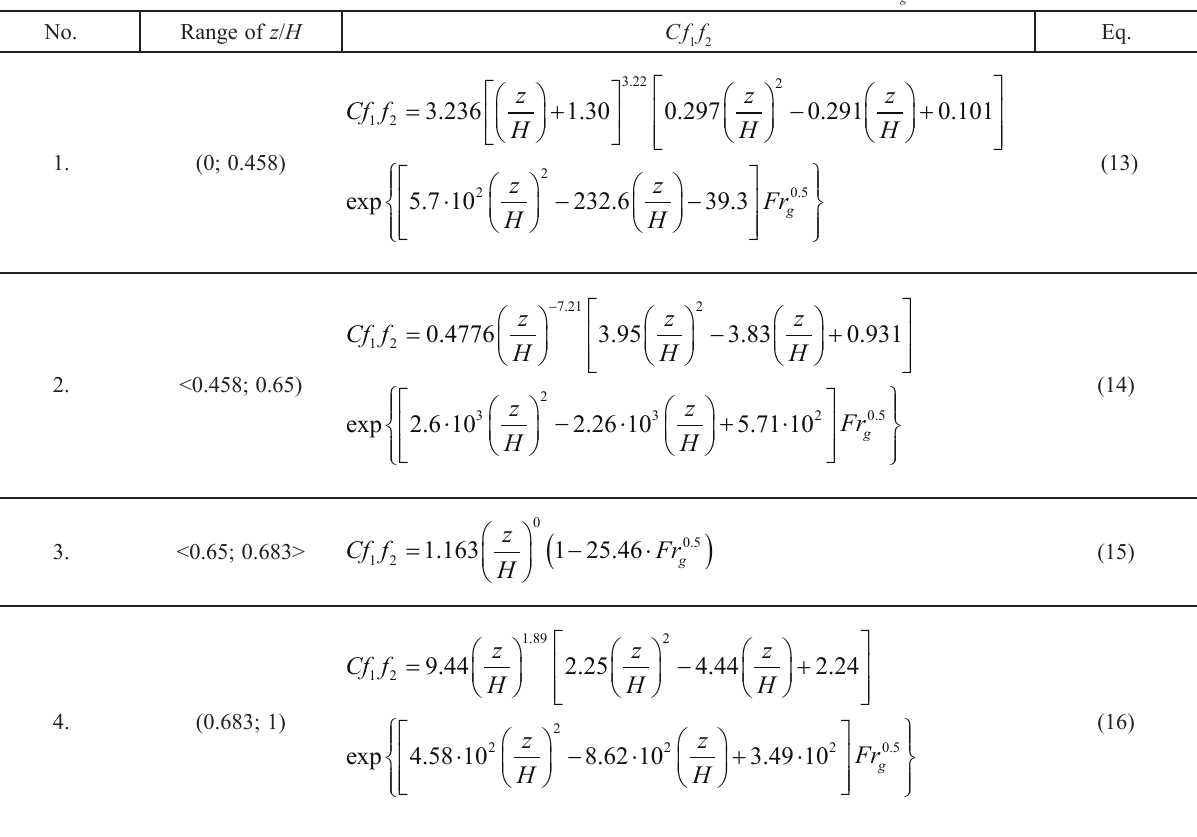
< 1.27 · 10 –5 ) g f 1